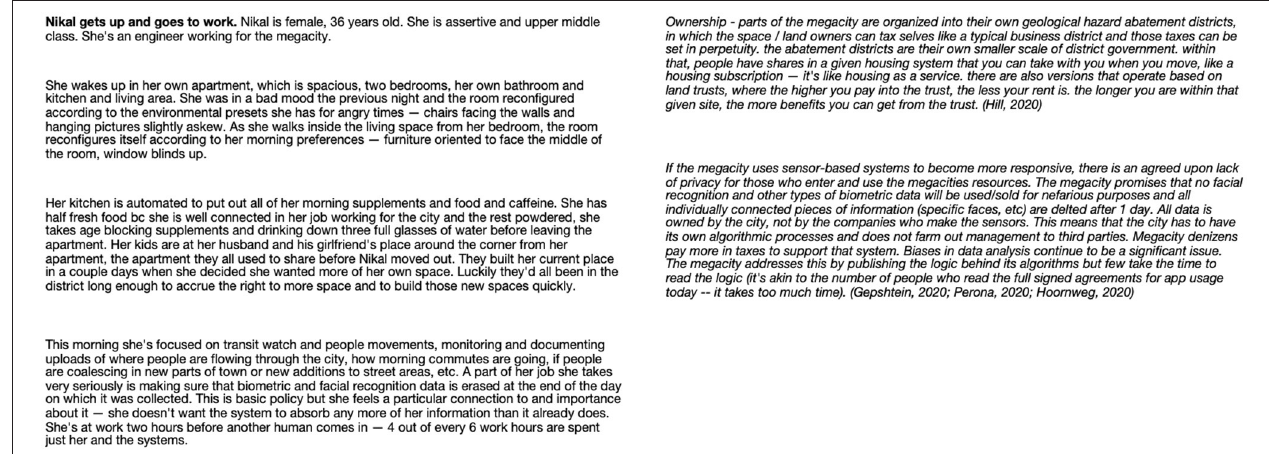
FIGURE 2 | Writing science fiction about residents’ daily lives helped synthesize the research and identify the range of experiences that people living in different neighborhoods might have. The right column shows takeaways of some of the research conducted. The left shows a story that resulted. The process kept the human experience of space as a key foundation of design (Hoffman,